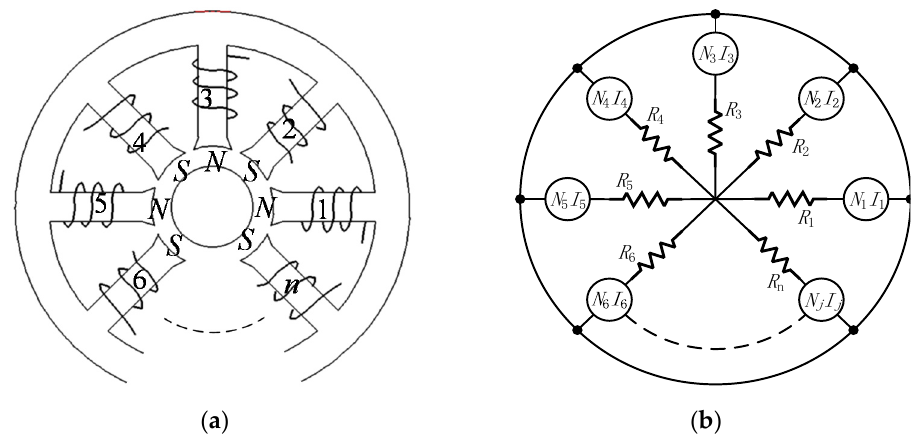
Figure 1. n pole bearing arrangement ( a ) and equivalent magnetic circuit ( b ).